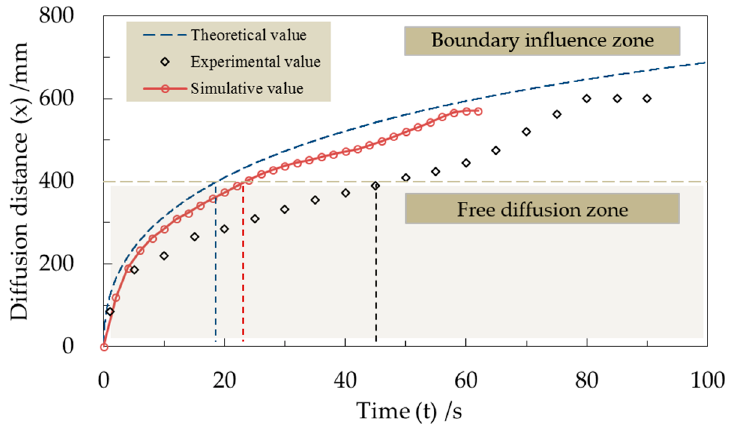
Figure 19. Comparison of the theoretical value, experimental value and simulative value.